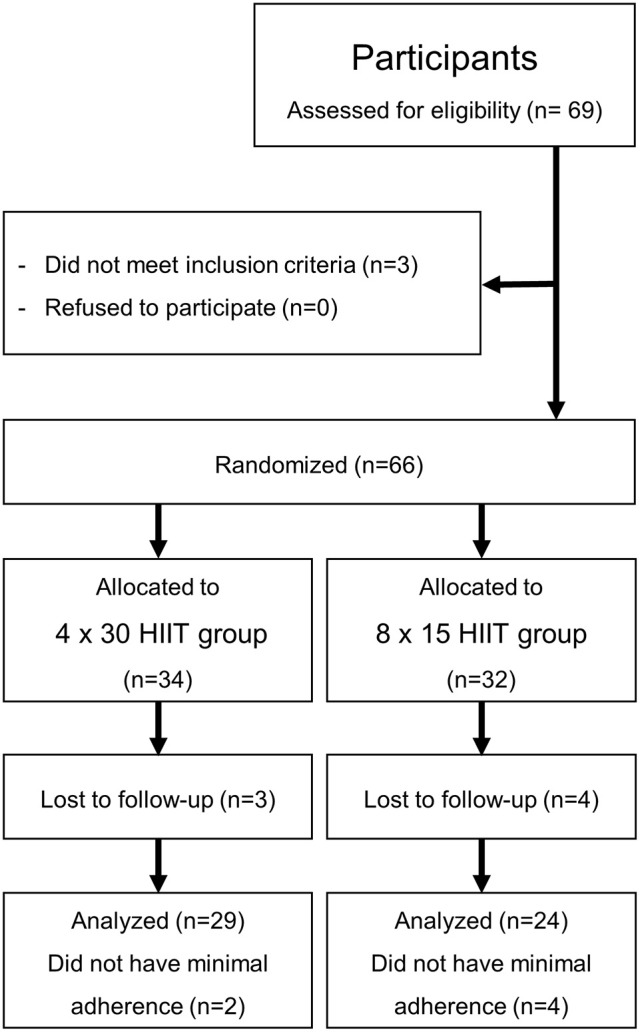
Study flow chart.